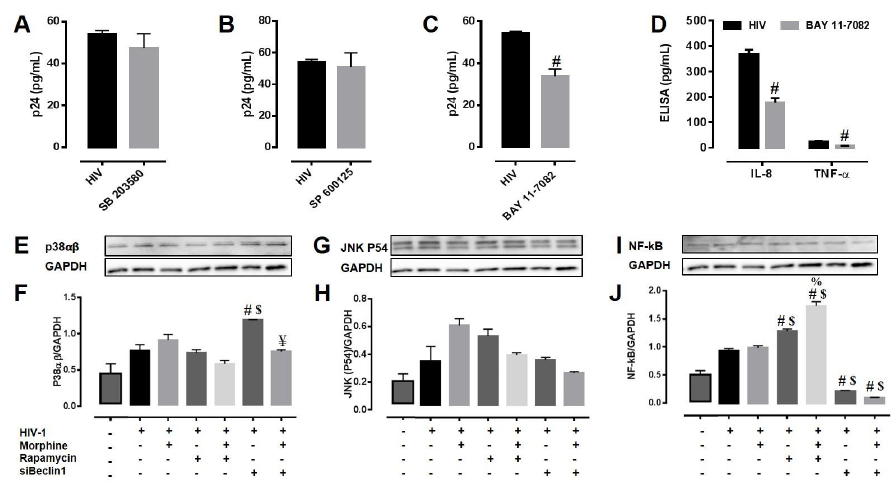
Figure 4. Autophagy-induced HIV replication and inflammation involves Mitogen activated protein kinases (MAPK) and nuclear factor kappa B (NF- κ B) pathway. ( A – C ) HIV virus production in culture media from HIV infected human astrocytes pre-treated with the inhibitors ( A ) SB 203580 and ( B ) SP 600125 and ( C ) BAY 11-7082 for 24 h were measured using HIV p24 Gag protein ELISA. Values were determined from standard curves and are presented as the mean ± the SEM of three independent experiments ( p < 0.05 # vs. HIV). ( D ) Corresponding cell culture supernatants were also used to detect the levels of pro-inflammatory cytokines IL-8 and TNF- α by ELISA. Values were determined from standard curves and are presented as the mean ± the SEM of three independent experiments ( p < 0.05 # vs. HIV). ( E – J ) Cell lysates from HIV infected astrocytes with the indicated treatments were subjected to immunoblotting with antibodies to ( E , F ) p38, ( G , H ) c-Jun N-terminal kinase (JNK) and ( I , J ) nuclear factor kappa B ( NF- κB ). Densitometry was performed for quantification, and the ratios of each protein to Glyceraldehyde-3-phosphate dehydrogenase (GAPDH) are presented graphically. Error bars show the SEM of three independent experiments ( p < 0.05 # vs. HIV, $ vs. HIV + MOR, % vs. HIV + RAP, ¥ vs. HIV + siBeclin1).